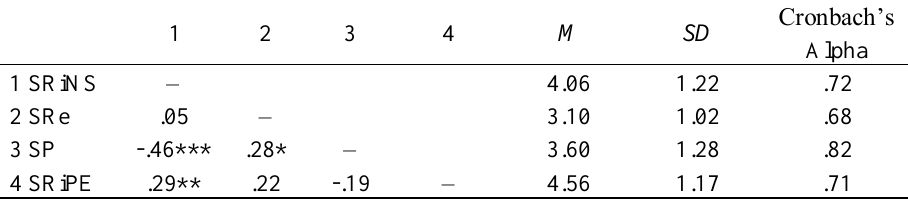
Factor Correlations for Latent Variables, and Descriptive Statistics and Cronbach’s Alphas from Composite Scores (Study